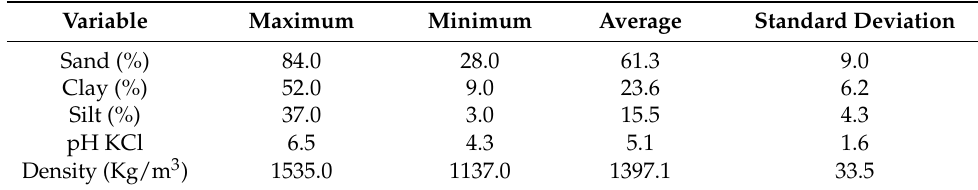
Table 1. Soil texture, soil density, and pH data in the Cerrado were obtained from the SoilGrids database and used to model carbon stocks in the pasture areas of the